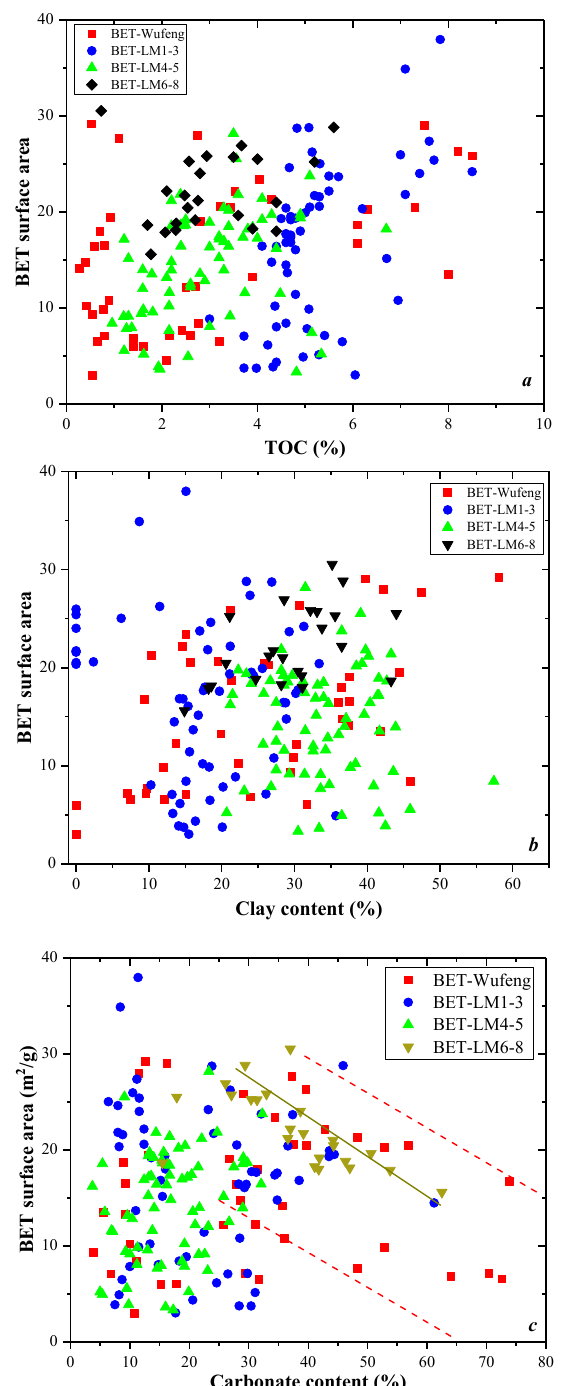
Figure 9. The correlations between BET surface area and TOC content ( a ), clay content ( b ), and carbonate content ( c ) of all 196 shale samples (sample L204-4 has an extremely large BET value, and is not presented in these figures. Data for sample L204-5: TOC-5.25%, quartz content: 65.8%; clay content-11.6%; BET-56.87 m 2 /g, BJH volume-0.0534 cm 3 /g).